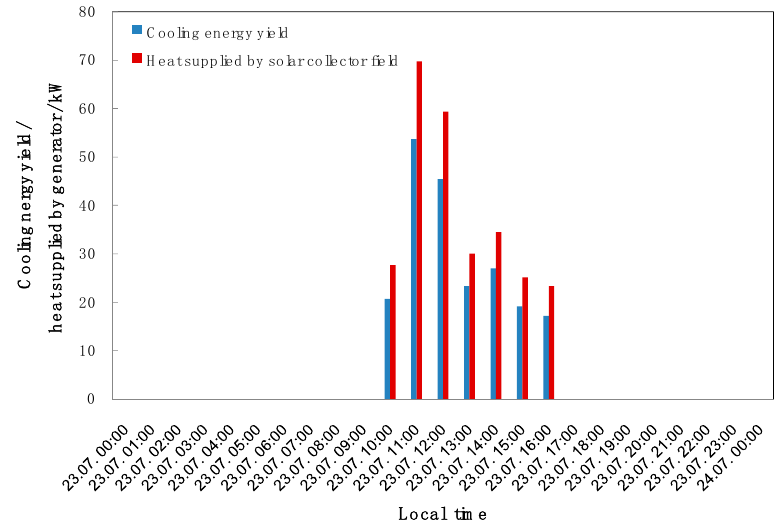
Figure 13. The hourly cooling energy yield of the absorption chiller and heat supplied by generator on 23 July 2018. 23 July 2018.